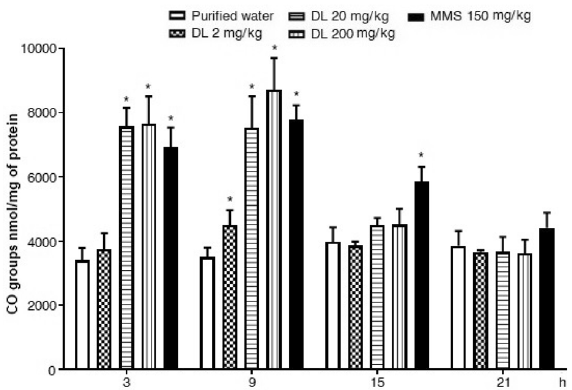
Figure 6. Effect of duloxetine (DL) and methyl metanesulfonate (MMS) on the content of oxidized carbonil groups (CO•) in mouse brain cells. Each bar corresponds to the mean ± SEM obtained in 5 independent determinations made in triplicate. *Statistically significant difference with respect to control value. ANOVA and post hoc Student–Newman–Keuls tests ( p ≤